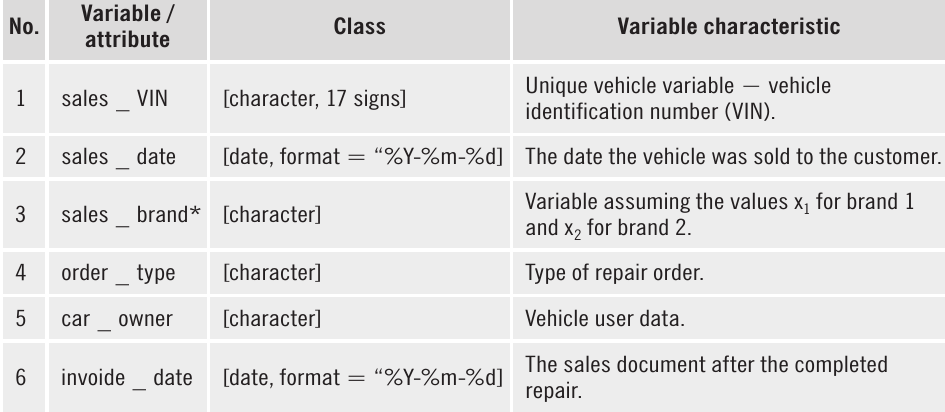
Table 3. Characteristics of the variables used in the retention database